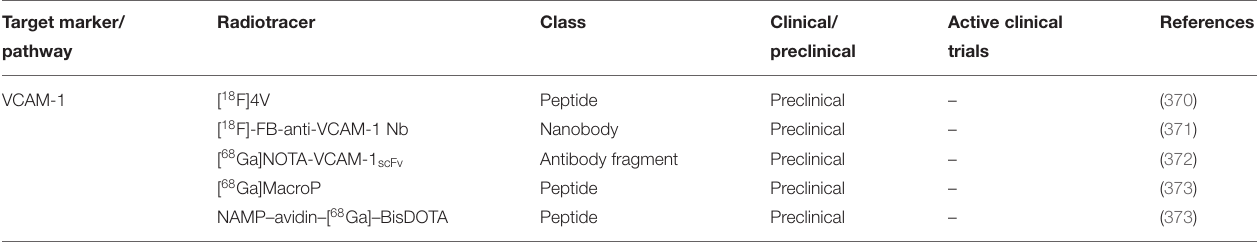
TABLE 5 | Adhesion molecule VCAM-1 targeted PET